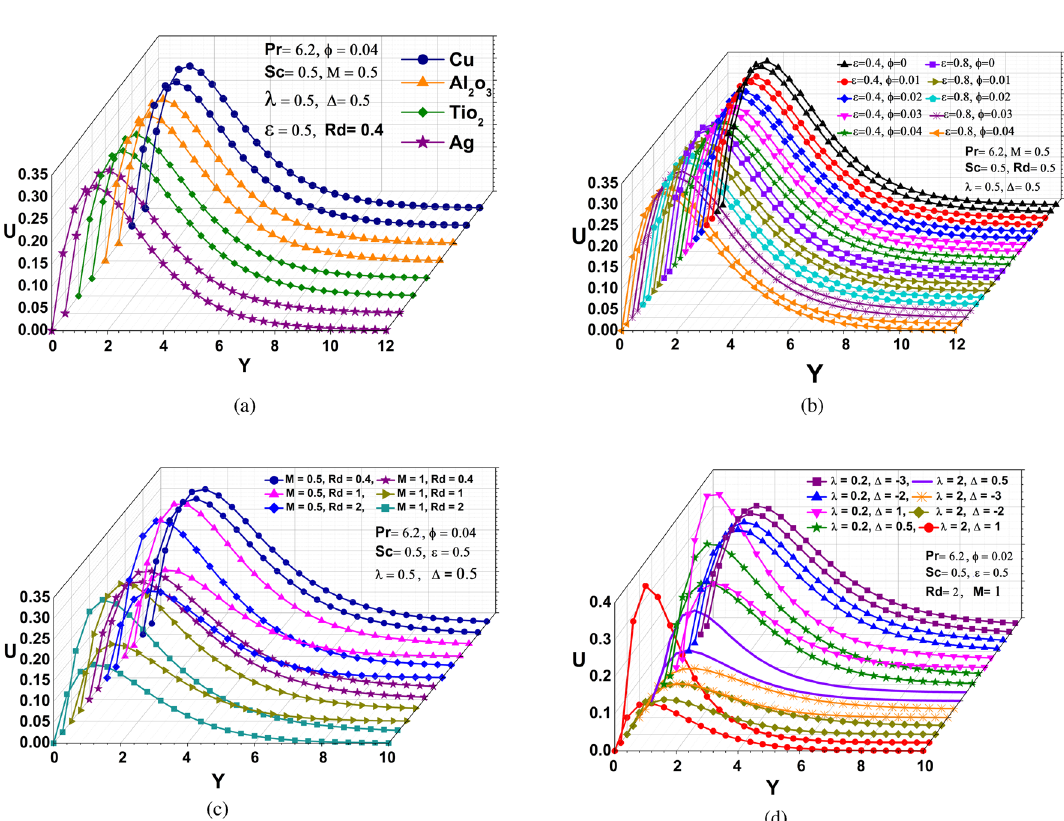
Figure 2. Velocity profiles: ( a ) different nanoparticles ( b ) various ǫ and φ ( c ) distinct M and Rd ( d ) different (cid:31) and (cid:31)